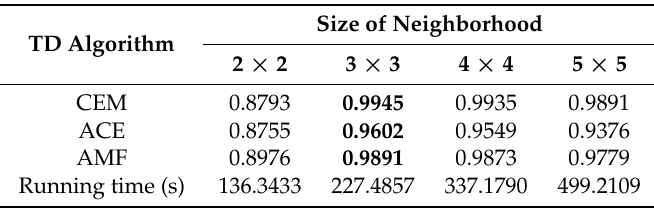
Table 3. AUCS and running time with different neighborhood sizes.